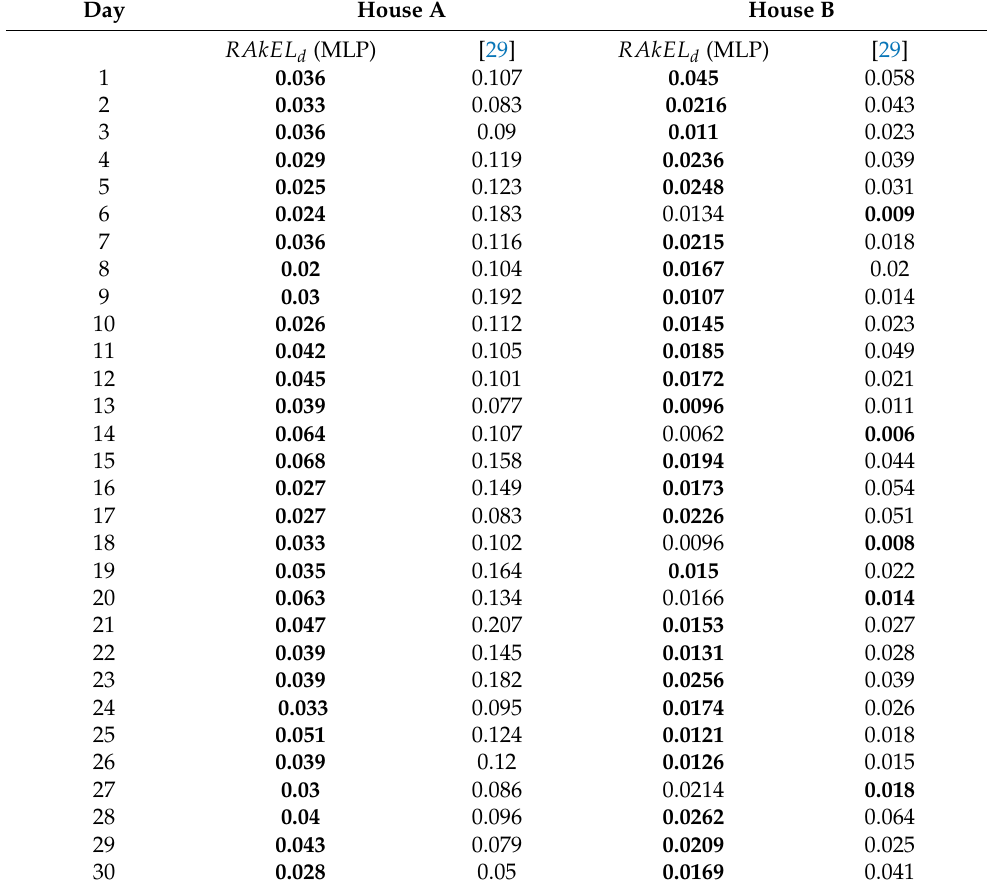
Table 10. Hamming loss comparison between RAkEL d (MLP) and results presented in [29].